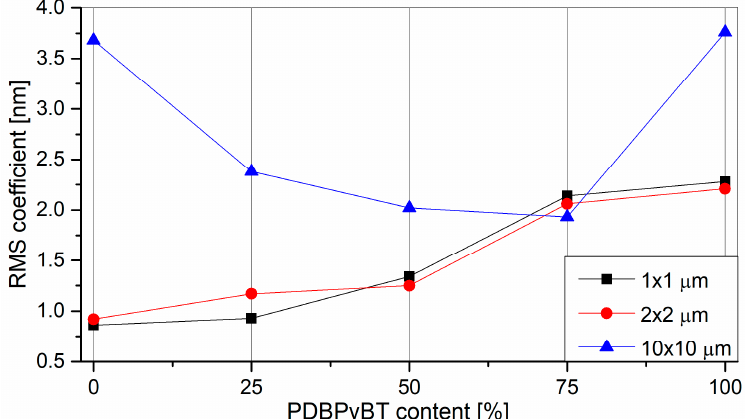
Figure 8. The mean square root of the roughness of the tested layers.